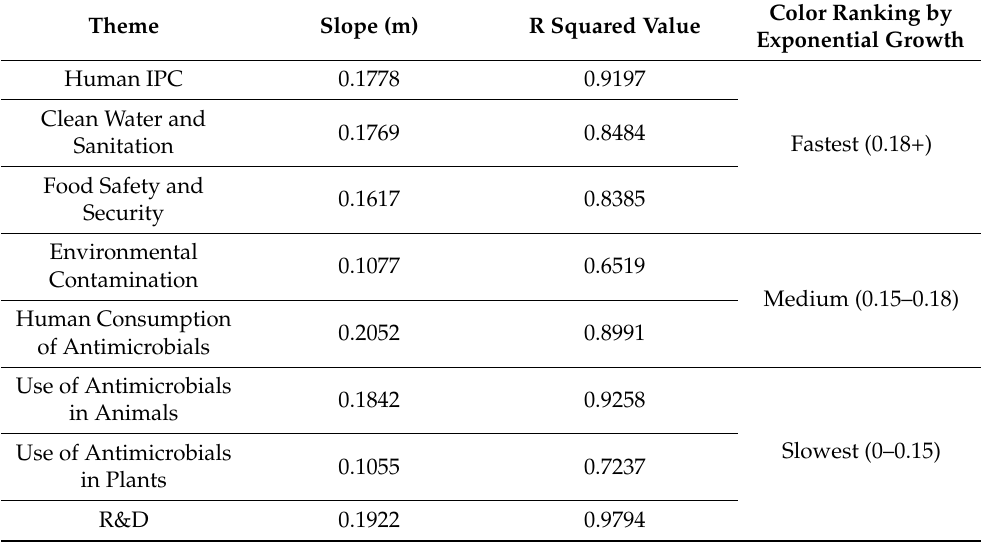
Figure 4. Trends of the article records from 1990–2020 in relation to AMR stewardship themes (Human Infection and Prevention Control (IPC); Research and Development (R&D)) ( n = 12,638). Table 4. Logarithmic linear regression slope and R squared values for each theme in relation to the trend analysis of the article records from